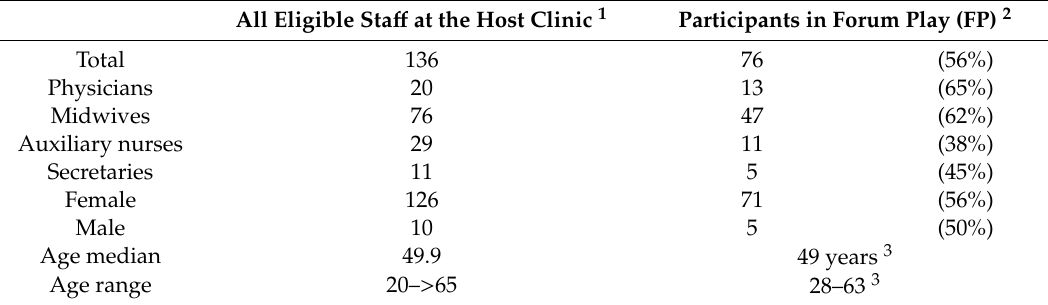
Table 2. Background characteristics of sta ff at the host